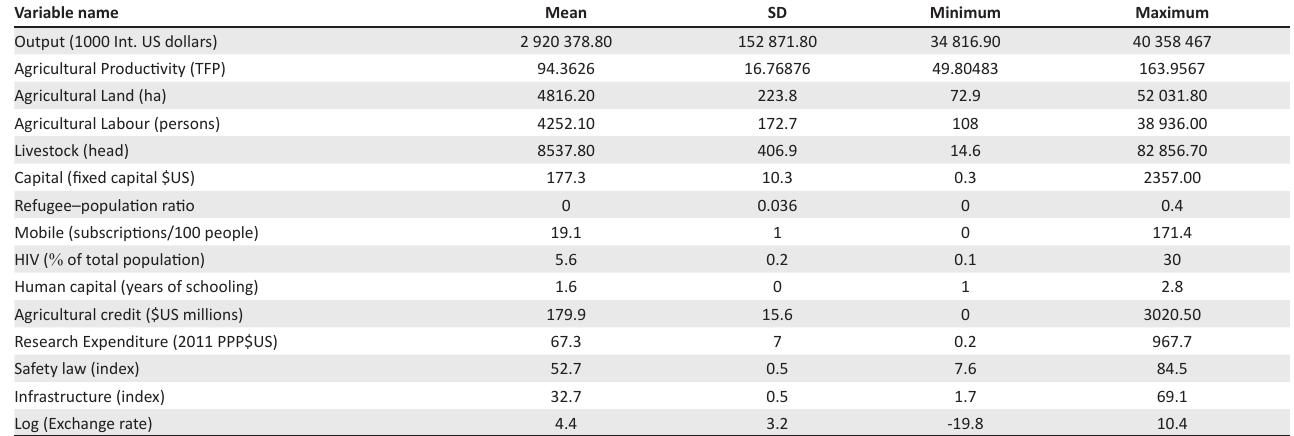
TABLE 3: Summary of descriptive